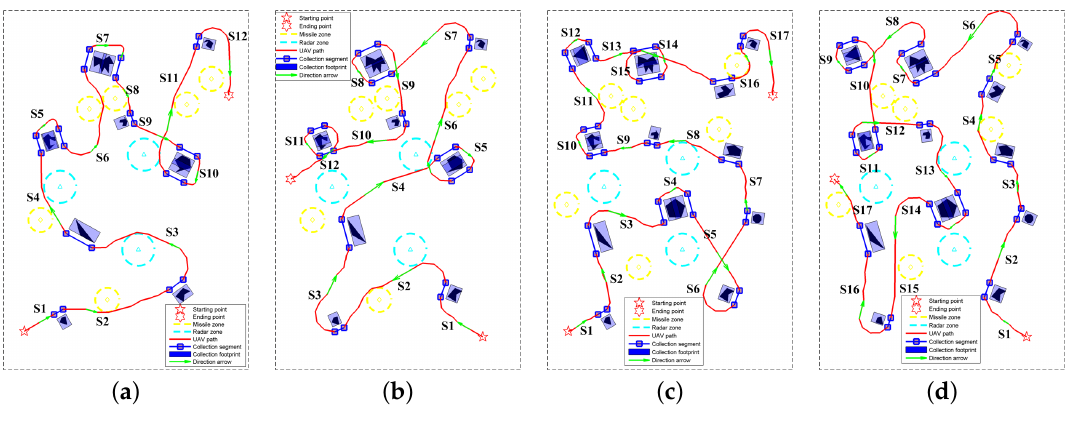
Figure 15. Designed path with more ROIs. ( a ) test case 5; ( b ) test case 6; ( c ) test case 7; ( d ) test case 8. Table 4. Computational time of the proposed path planner in different